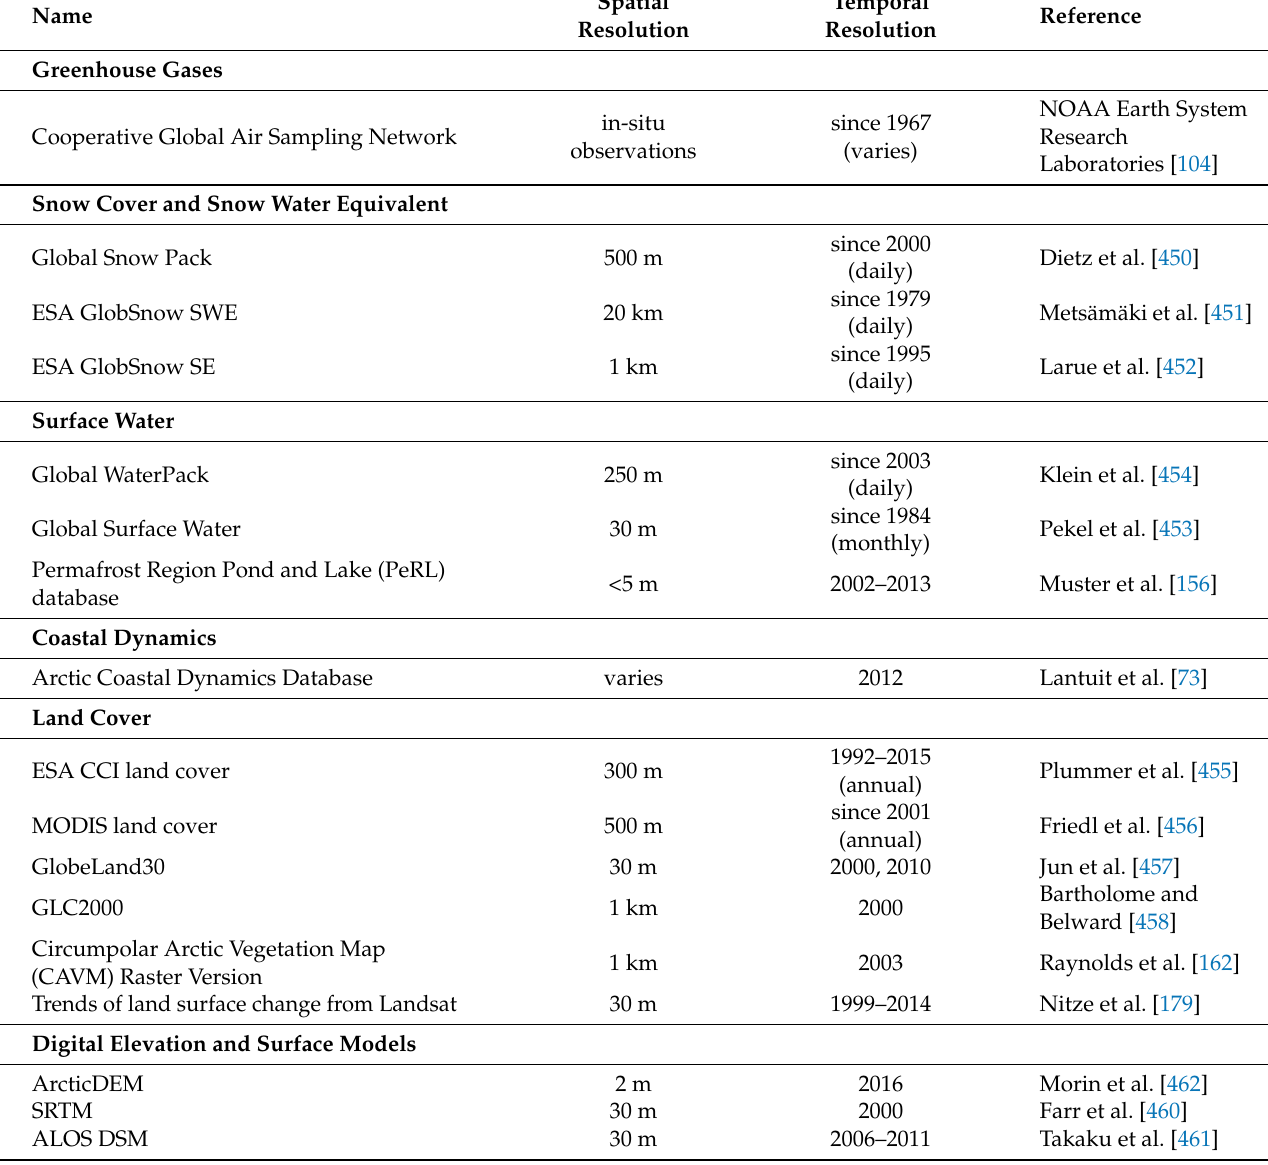
Table 4. Overview of a variety of permafrost related and openly available products. The column “Temporal Resolution” shows the covered time span and in parenthesis the temporal frequency of available data, if more than one scene is available within the time